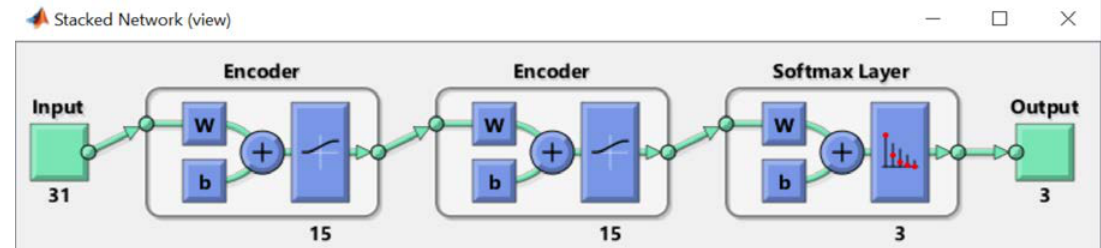
Figure 2. Deep Network diagram